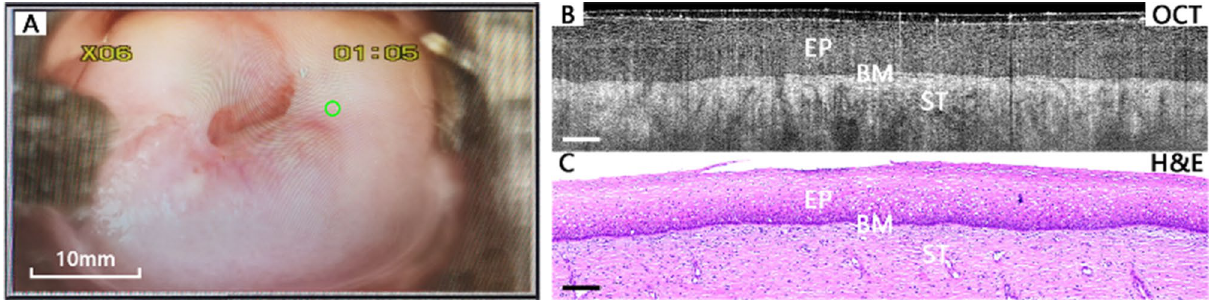
Figure 2. A typical case of normal cervical tissue. Colposcopy image ( A ), OCT image ( B ), and the corresponding histological image ( C ). The basal membrane (BM) can be clearly visualized, which forms the boundary between the epithelium (EP) and stroma (ST). Scale bars 200 μm. H&E magnification: 10